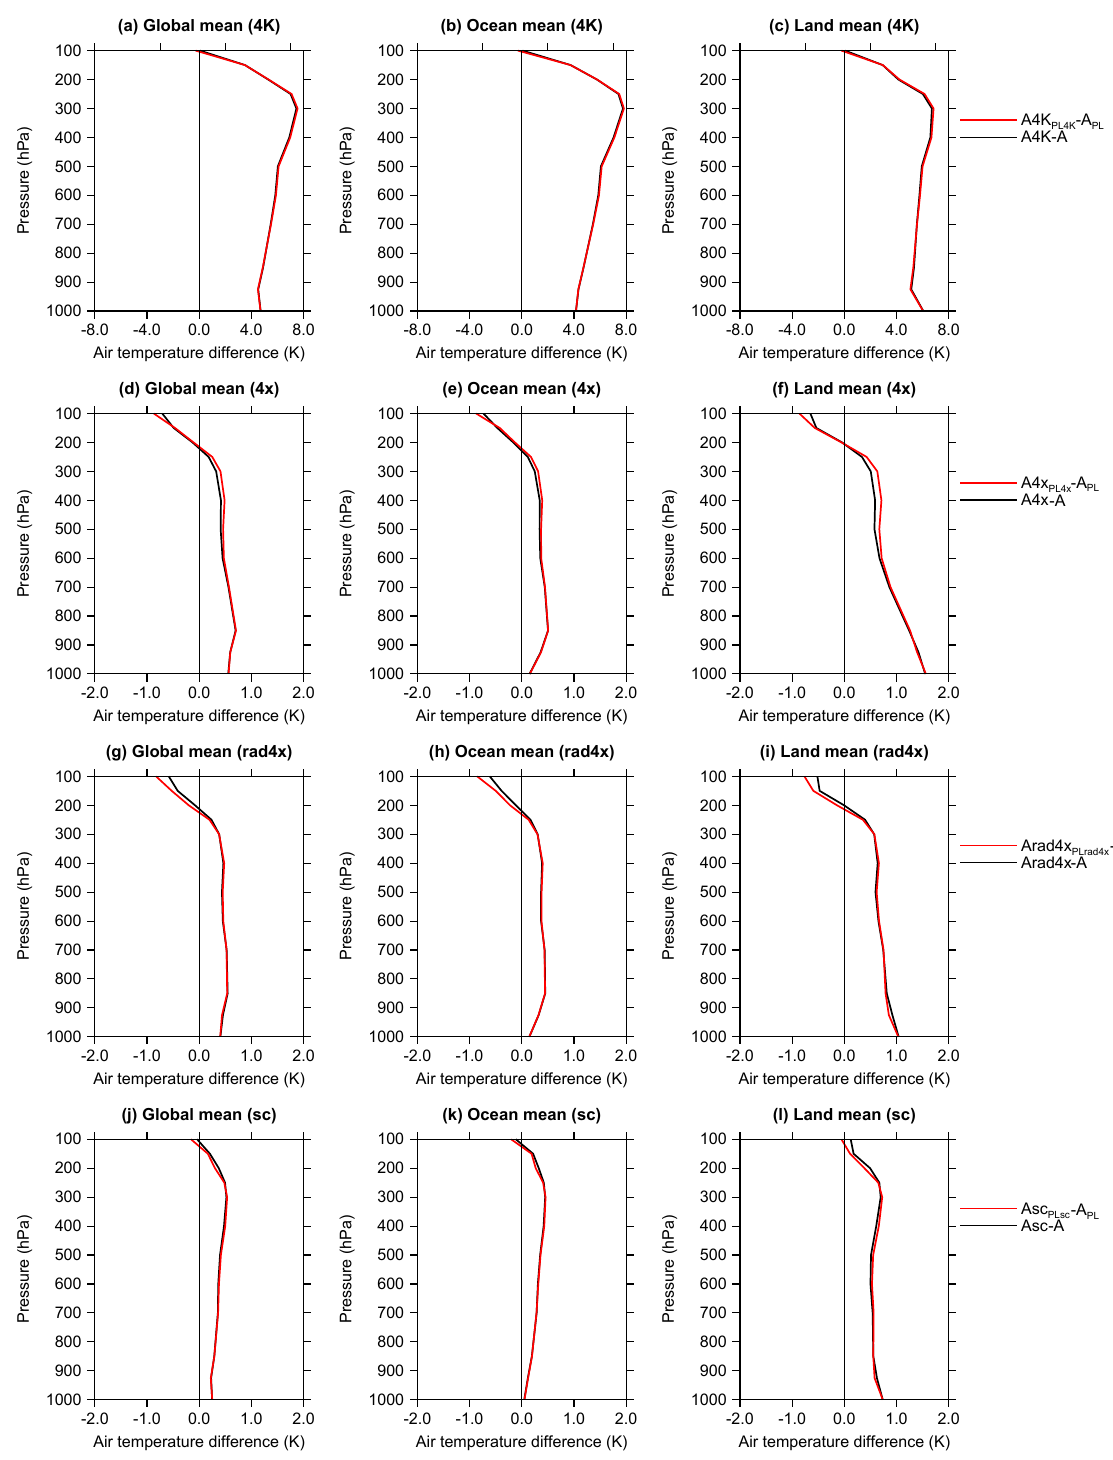
Figure 3. Differences (relative to A or A PL ; see key for each row) in global mean (a, d, g, j) , ocean-only mean (b, e, h, k) and land-only mean (c, f, i, l) air temperature (K) for (a–c) the A4K experiments, (d–f) the A4x experiments, (g–i) Arad4x experiments and (j–l) the Asc experiments,